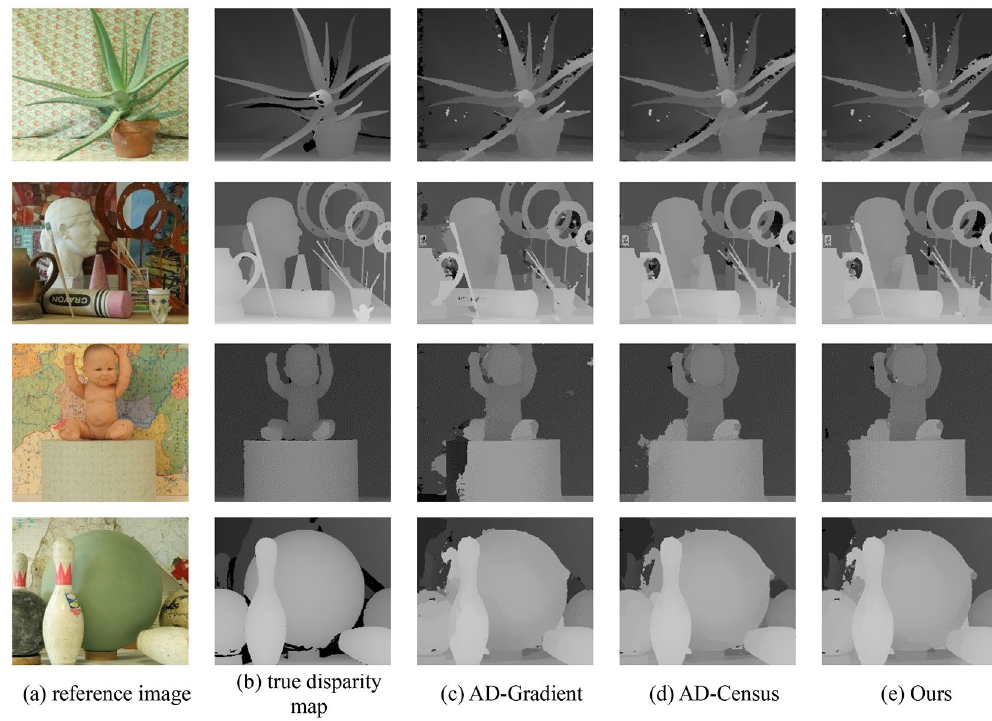
Figure 7. Disparity maps generated by different cost computation methods.